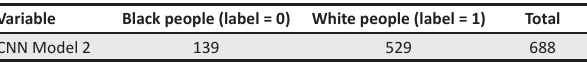
TABLE 4: Results.